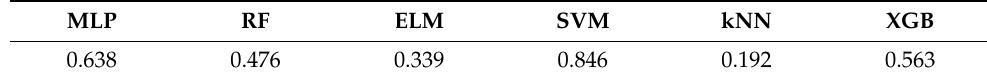
Table 11. Evaluation time of different classifiers (in